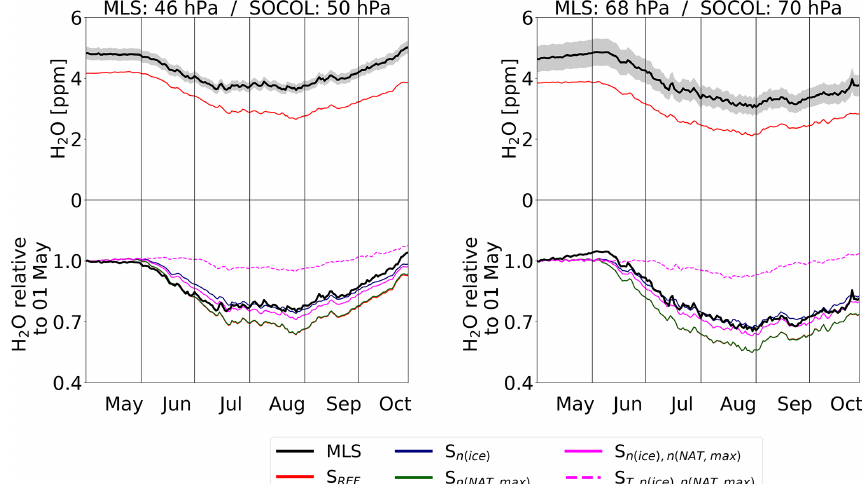
Figure A12. As Fig. 8, but for the year